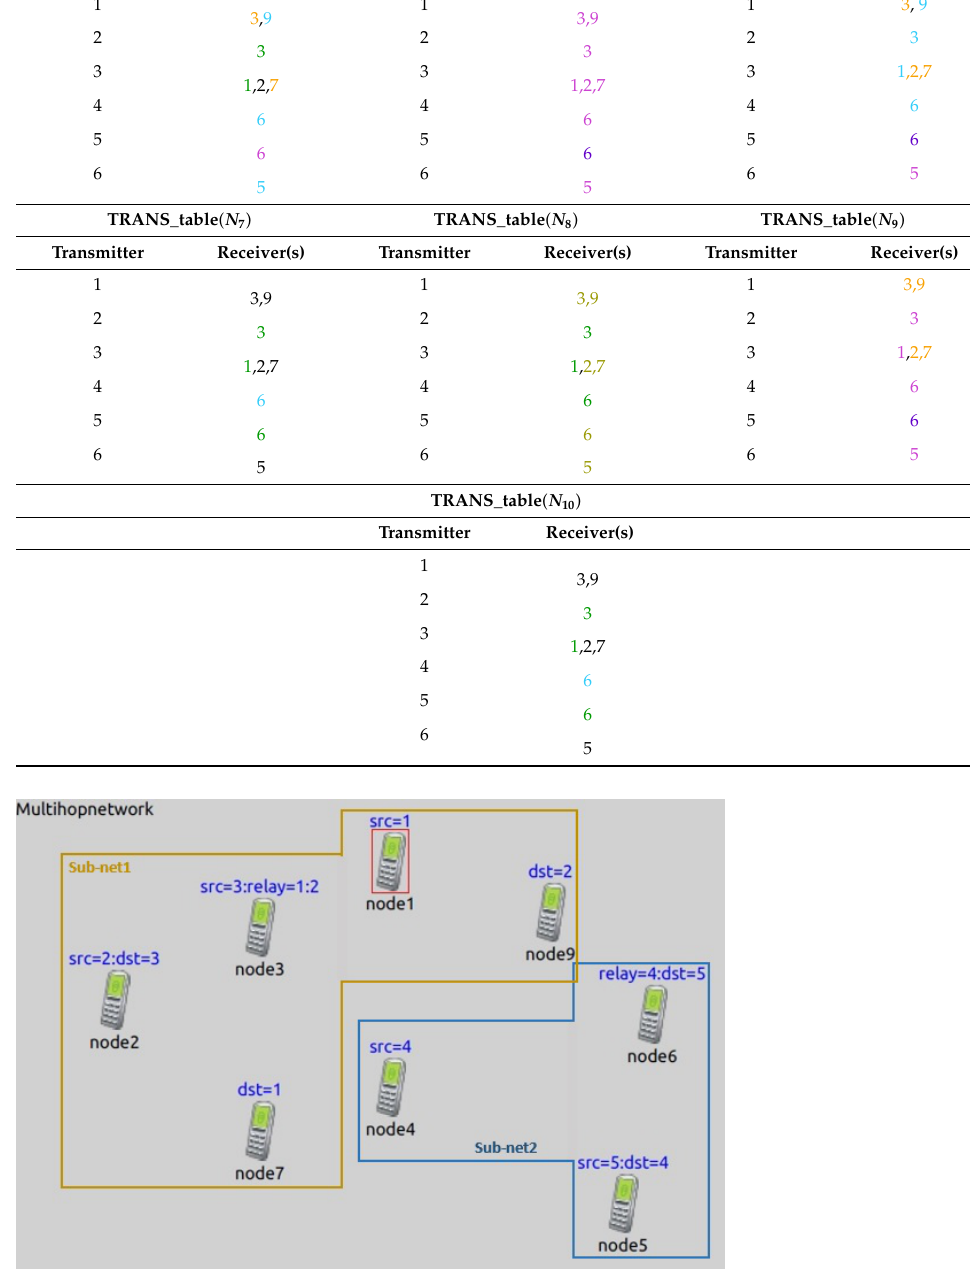
Figure 12. Sub-nets formation after control frames